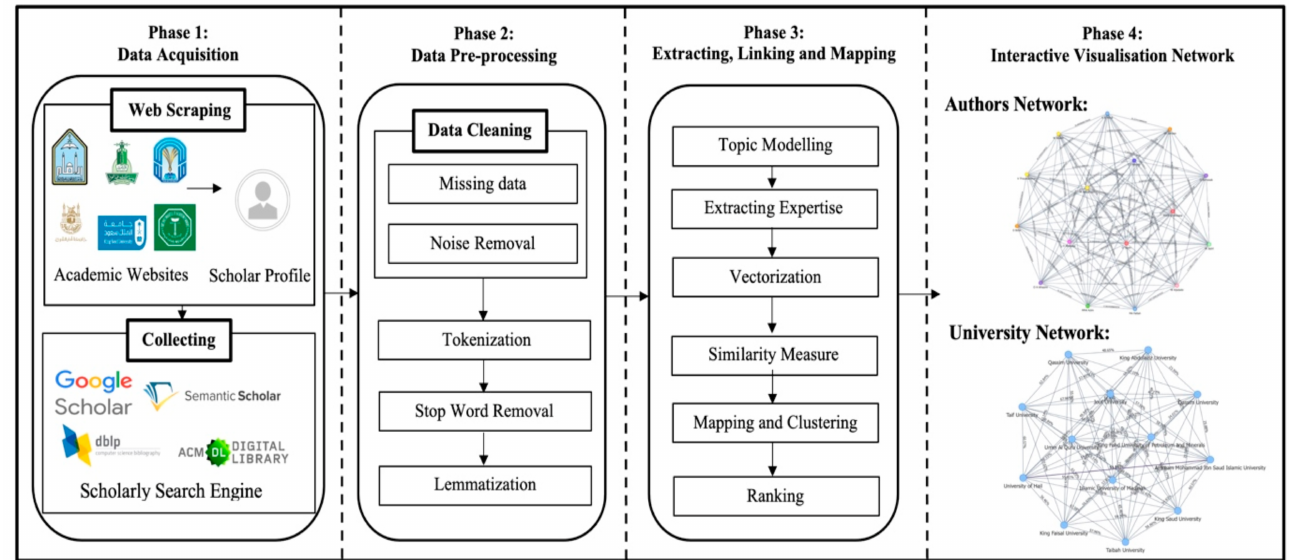
Figure 3. The proposed approach of the academic